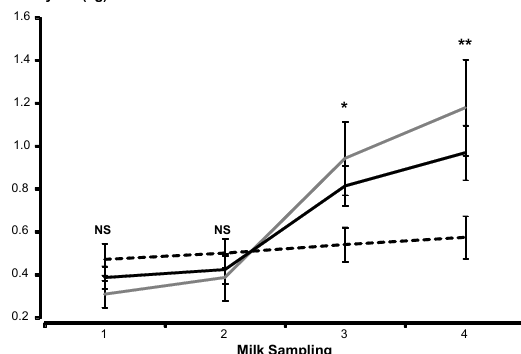
Figure 3. Milk yield ( ± SEM) from week 1 up to weaning (60 days; sampling 4) in Rambouillet ewes that received alfalfa (Control; grey line), untreated Opuntia (black solid line), or protein-enriched Opuntia (E-Opuntia; black dotted line) during late gestation. NS: not significant; * p < 0.05; ** p < 0.01; *** p <